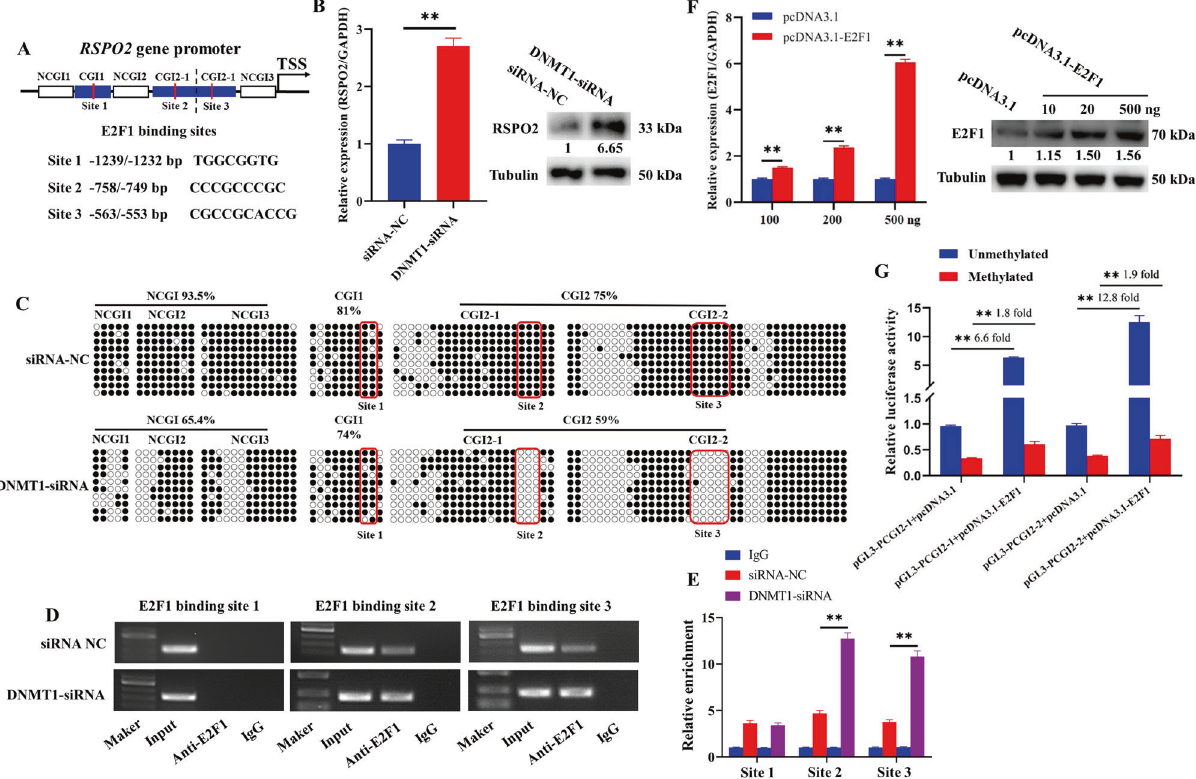
Fig. 7 Hypomethylation of CGI2 recruited E2F1 to promote the transcription of RSPO2 . A Predicted E2F1 -binding sites in the CGI1 and CGI2 region of RSPO2 promoter. B The mRNA and protein expression level of RSPO2 in porcine GCs treated with DNMT1-siRNA. The numbers below bands were folds of band intensities relative to control. The band intensities were measured by ImageJ and normalized to Tubulin. C BSP was used to detect the NCGI and CGI methylation status of RSPO2 in porcine GCs treated with DNMT1-siRNA. The red box showed the three potential binding sites region of E2F1 in the RSPO2 promoter CGI. D , E The enrichment of E2F1 on the CGI region after DNMT1 knockdown was detected by ChIP ( D ) and ChIP-qPCR ( E ). F The mRNA and protein expression levels of E2F1 after transfection with pcDNA3.1 or pcDNA3.1- E2F1